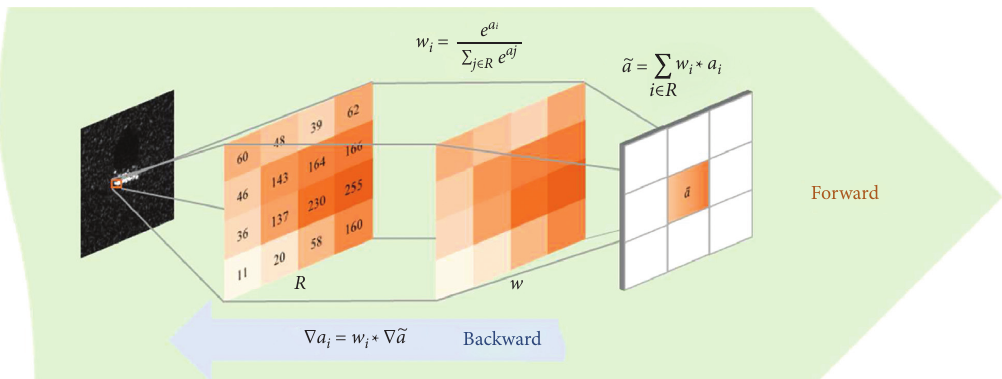
Figure 5: The green part represents forward propagation. The output of pooling is the product of the weights and activation values in region R . The blue part represents backward propagation, and the update of the activation value is also related to the weight.